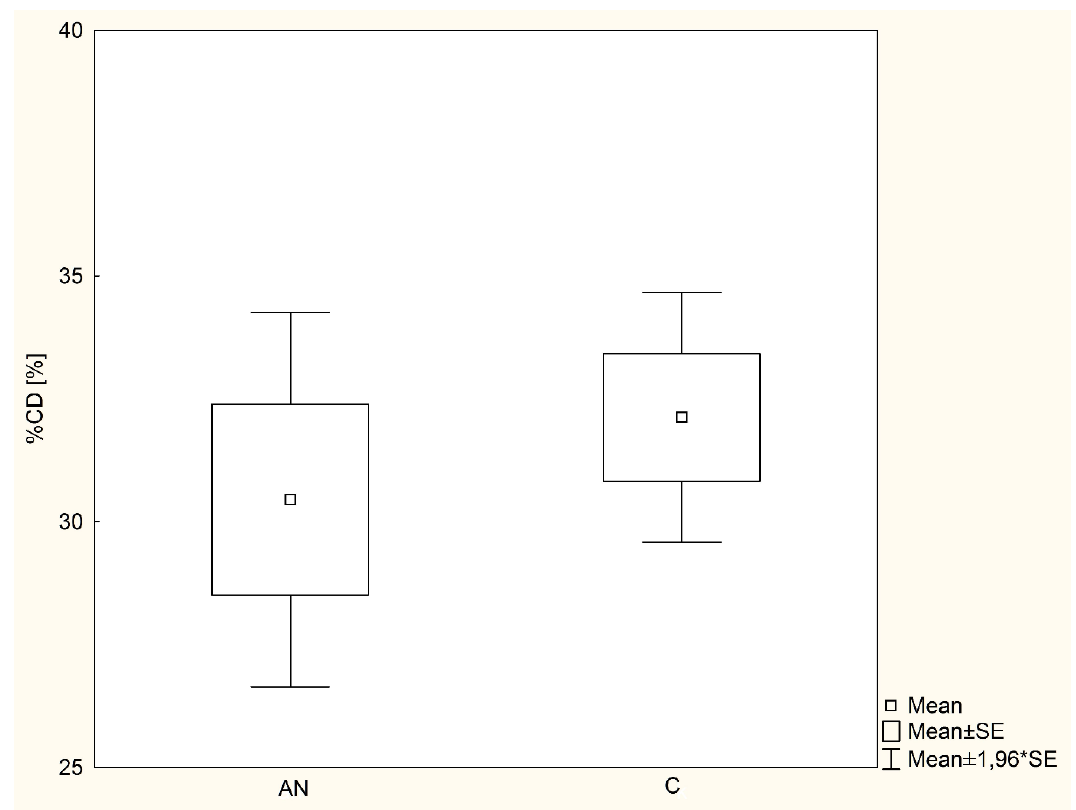
Figure 1. Cumulative dose of 13 C-triglycerides recovered with expiratory air in MTG-BT in examined girls with anorexia nervosa and healthy controls. p = 0.49; SE — standard error; AN — anorexia nervosa; C — healthy controls; %CD — cumulative dose of 13 C-triglycerides recovered with expiratory air in MTG-BT. The values of %CD indicating pancreatic exocrine failure in the lipase range (<22%) were found in six girls with anorexia nervosa (7.8%) and two subjects from the control